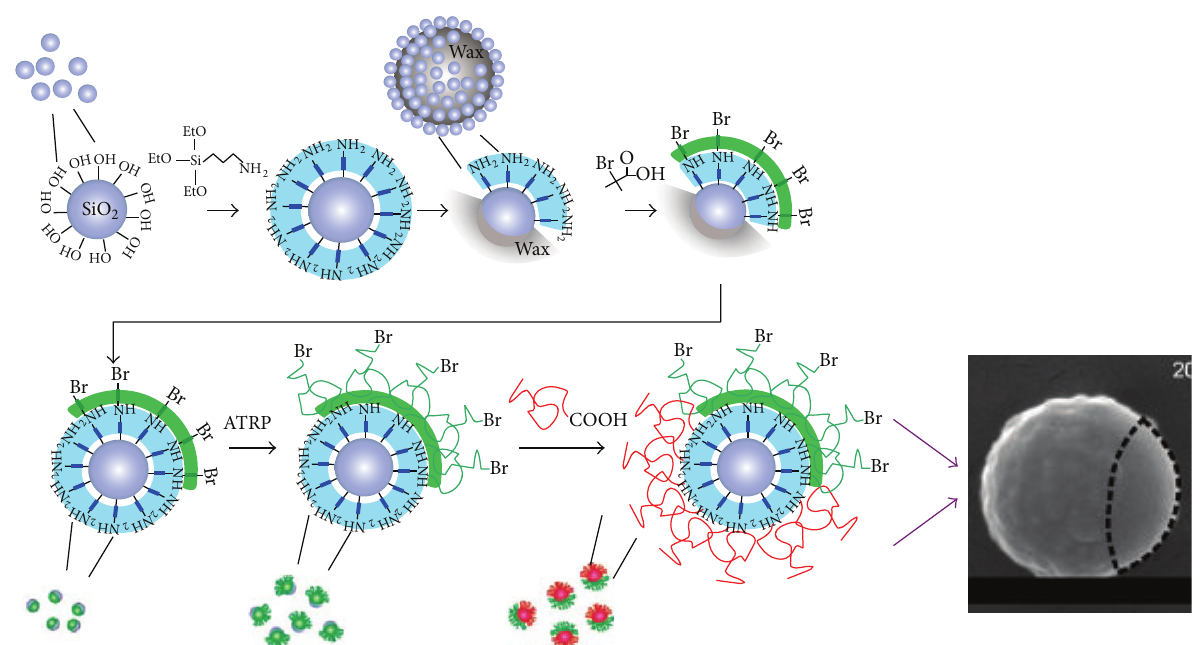
Figure 4: Synthesis of biocomponent Janus particles by “grafting from” and “grafting to” approaches (reproduced from [72], with permission from American Chemical